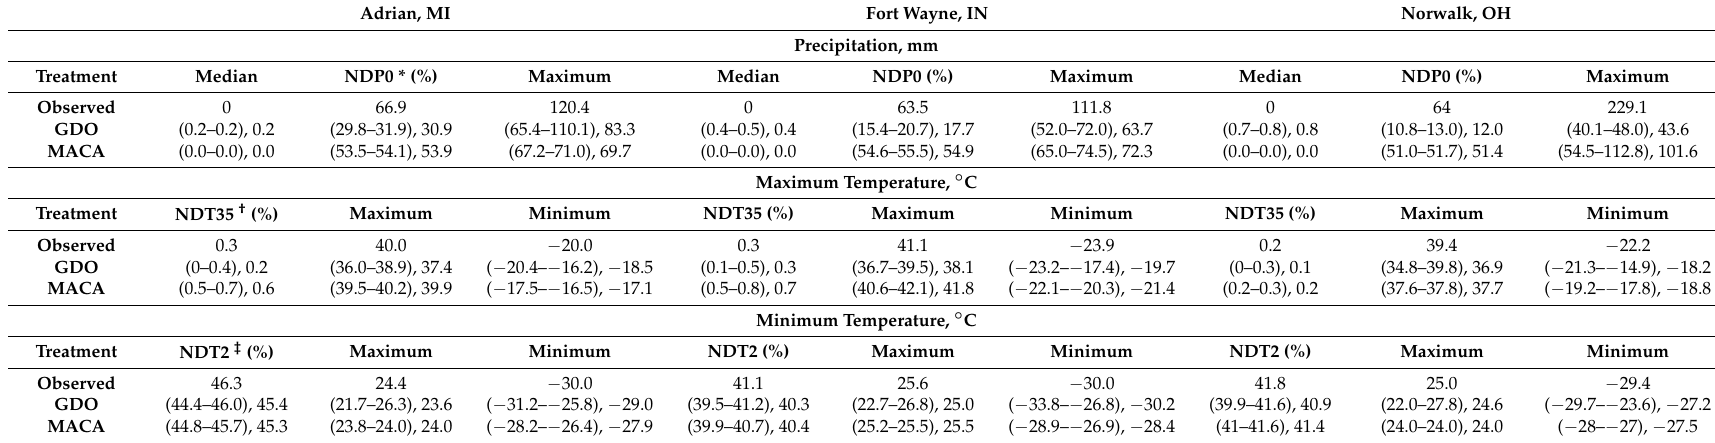
Table 3. Comparison of GDO and MACA climate projection sources for Adrian, MI, Fort Wayne, IN, and Norwalk, OH in simulating descriptive statistics for daily precipitation (mm), and maximum and minimum air temperatures ( ◦